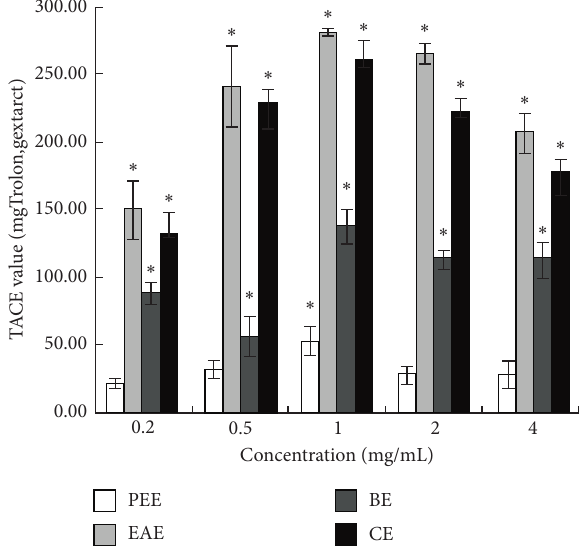
Figure 2: TEAC value (Trolox mg/g extract) of four extracts. ∗ P < 0 . 05 vs. the blank